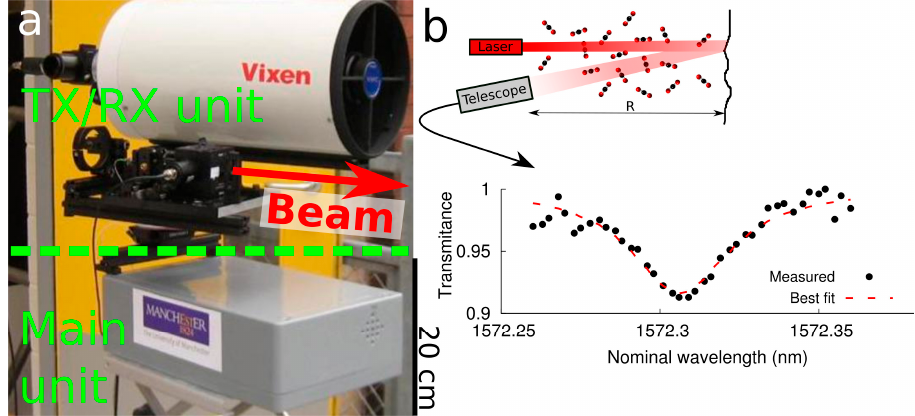
Figure 2. Overview of LARRS. ( a ) Photo of LARRS with the TX/RX unit and detachable main unit; ( b ) Scheme of the working principle with an example spectrum from a field measurement.